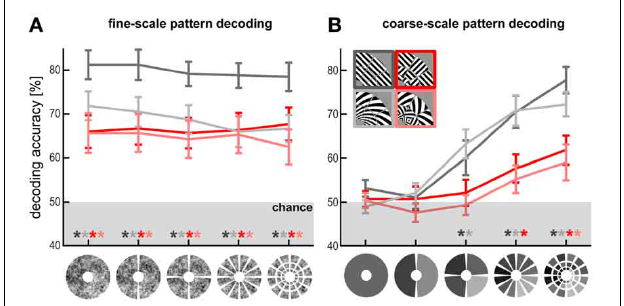
FIGURE 2 | Fine- and coarse-scale pattern components enable orientation decoding. (A) Fine-scale pattern decoding. V1 decoding accuracy after subtracting out patch-average activation levels (i.e., removing the spatial low-frequency component) from the patterns at different scales. Patch sizes, from coarse to fine (left to right): full-field representation (1 patch), hemifield representations (2 patches), quarterfield representations (4 patches), 30 ◦ radial-wedge representations (12 patches), and each radial wedge divided further into three equally sized cortical patches representing different eccentricities (36 patches). (B) Coarse-scale pattern decoding. V1 decoding accuracy based on only the patch averages using the same patch